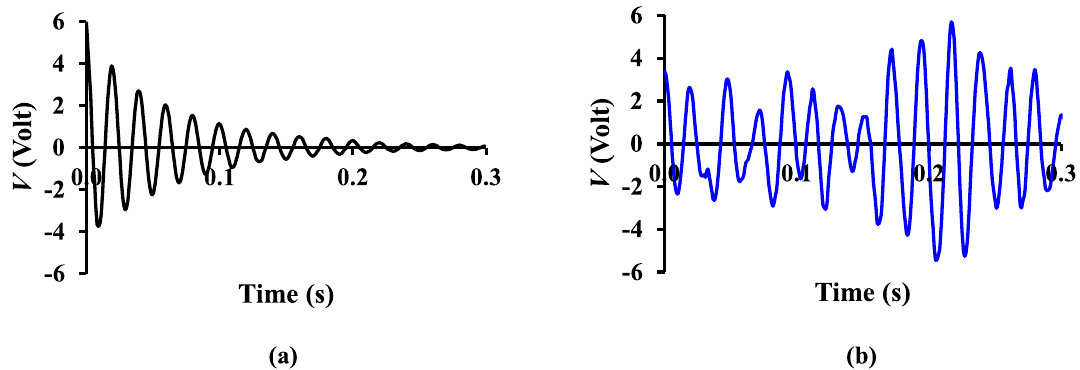
Figure 4. Time history of the piezoelectric voltage V ( a ) by lightly flicking the thin-film’s tip in the absence of air flow, and ( b ) at x / D h = 0.425 leeward of SFG